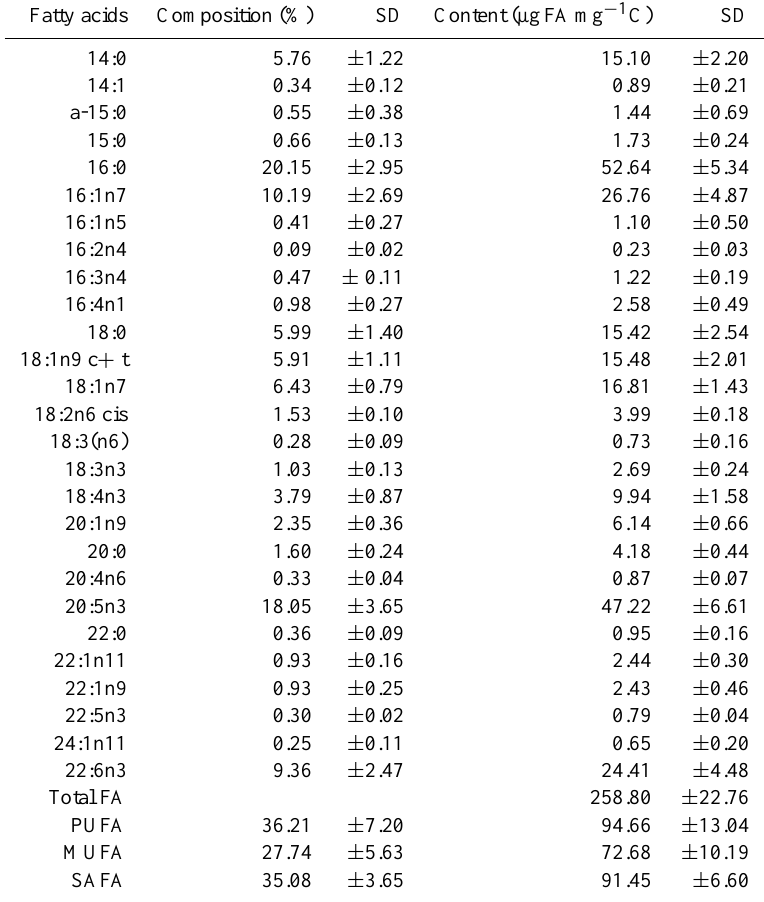
Table 3. Fatty acid (FA) composition (%) and content (standardized to µgFAmg − 1 C) of cirripedia nauplii. Values are averages of three replicates and standard deviation (SD). Each sample was comprised of 120